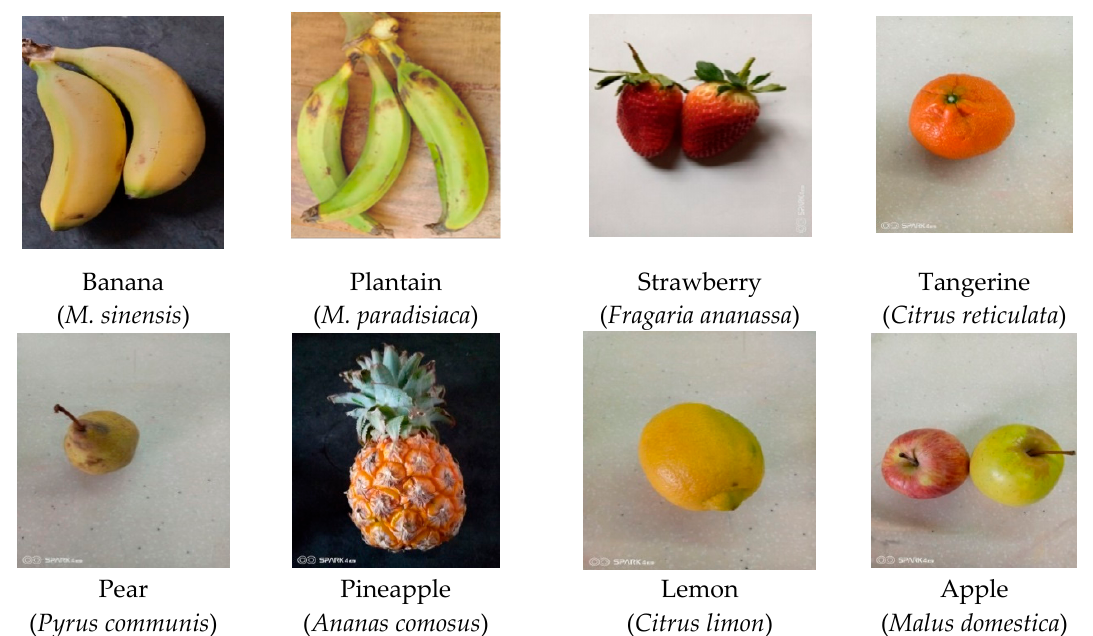
Figure 1. Photos of commonly consumed fruits including M. sinensis and M. paradisiaca .